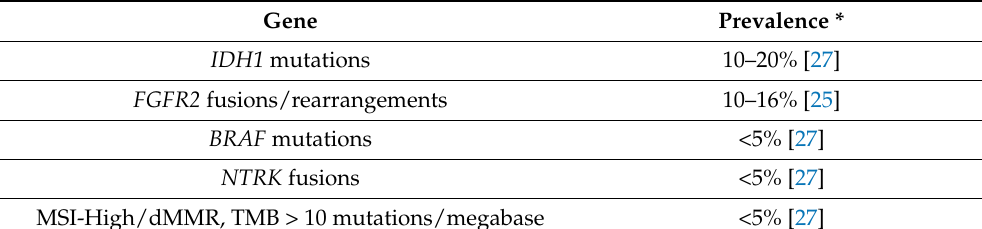
Table 1. Actionable genetic aberrations in iCCA. Gene Prevalence * IDH1 mutations 10–20% [27] FGFR2 fusions/rearrangements 10–16% [25] BRAF mutations NTRK